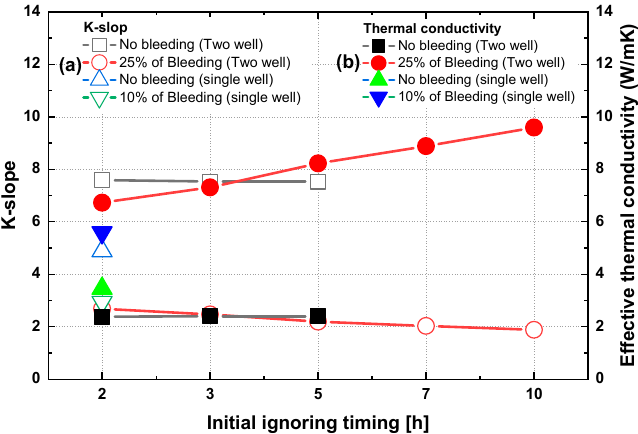
Figure 12. Effective thermal conductivity characteristic under no bleeding and bleeding conditions for single- and two-well type SCW systems: ( a ) k-slope; ( b ) effective thermal conductivity.